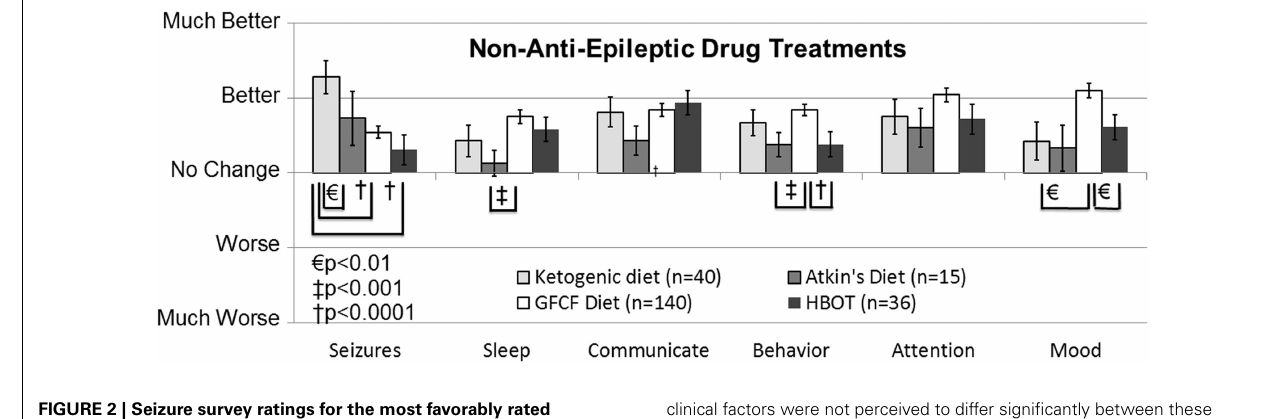
FIGURE 2 | Seizure survey ratings for the most favorably rated non-anti-epileptic drug treatments for clinical seizures .The ketogenic diet was perceived to improve seizures more than the gluten-free-casein-free diet and hyperbaric oxygen treatment. Other